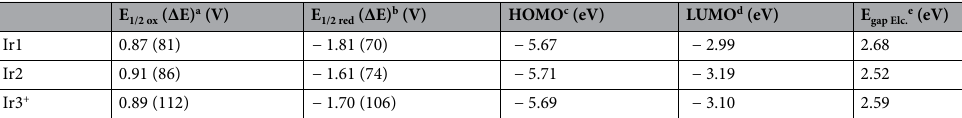
Table 2. Electrochemical properties of complexes Ir1, Ir2, Ir3 + . a Half-wave potential, E 1/2 = ½ (E pa + E pc ); 0.1 M acetonitrile/TBAP versus Ag/AgCl at a scan rate of 100 mV/s, Values in parentheses: difference between the anodic and cathodic peak potentials, ΔE = E pa − E pc (mV). b The half-wave potential of reduction peak for complexes. c From E HOMO = − (4.8 + E ox ) eV. d From E LUMO = − (4.8 + E red ) eV. e Electrochemical band gap from E gap = E HOMO − E LUMO